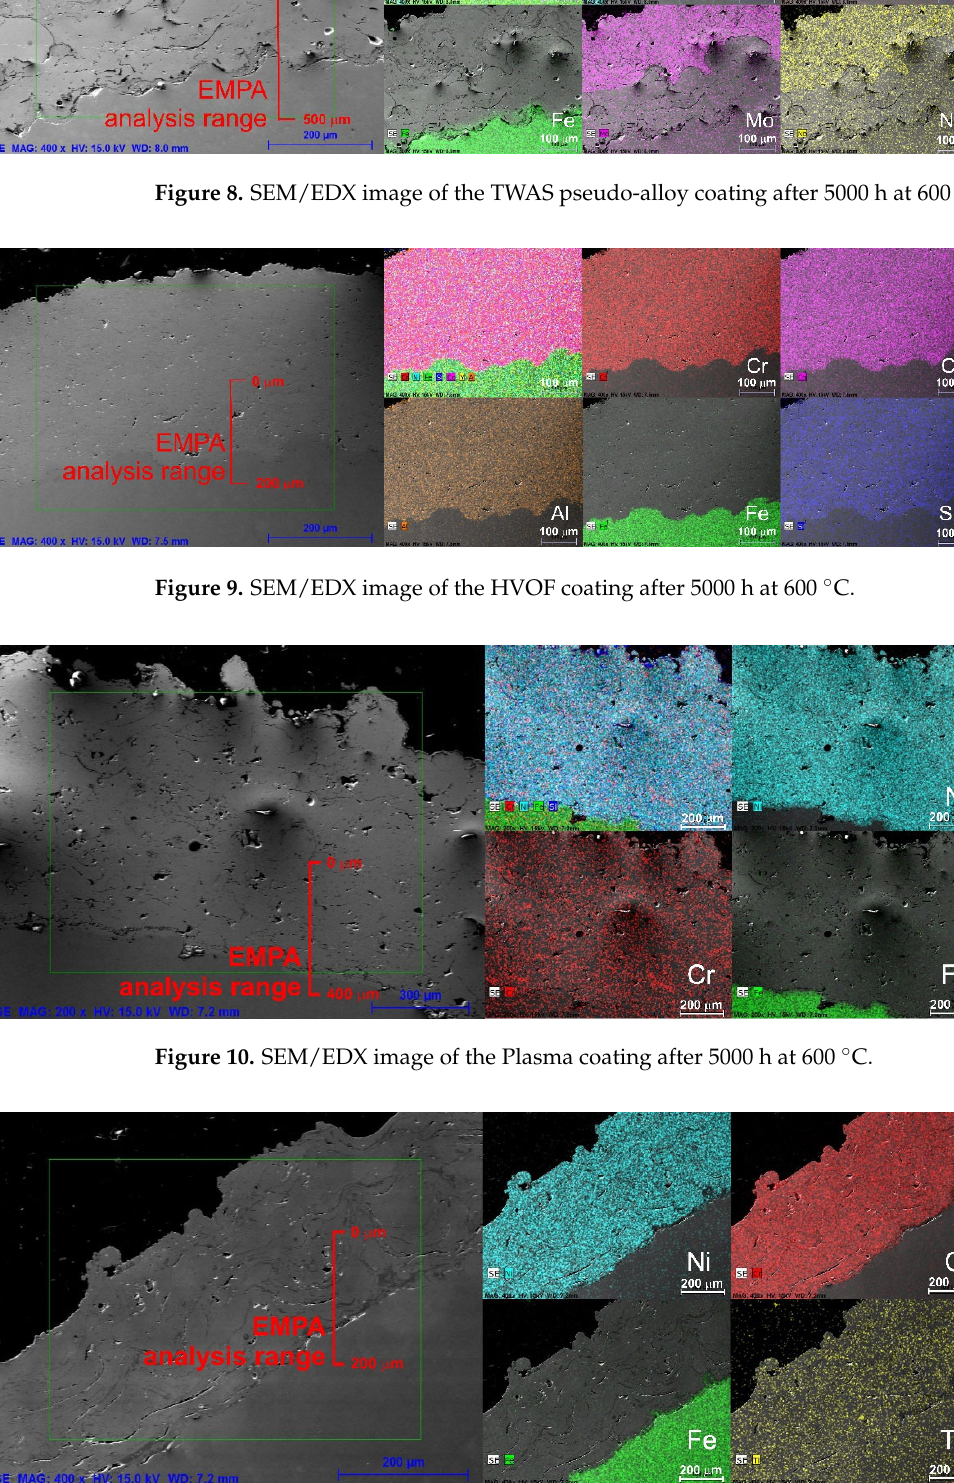
( a ) ( b ) Figure 12. Chemical analysis of the coatings performed by EMPA with 20 μ m steps (each point is the average of 10 separate measurements). ( a ) TWAS—pseudo ‐ alloy; ( b ) HVOF. ( a ) ( b ) Figure 13. ( a ) Chemical analysis of the coatings performed by EMPA with 20 μ m steps (each point is the average of 10 separate measurements). ( a ) Plasma; ( b ) TWAS—45CT4. 4. Discussion